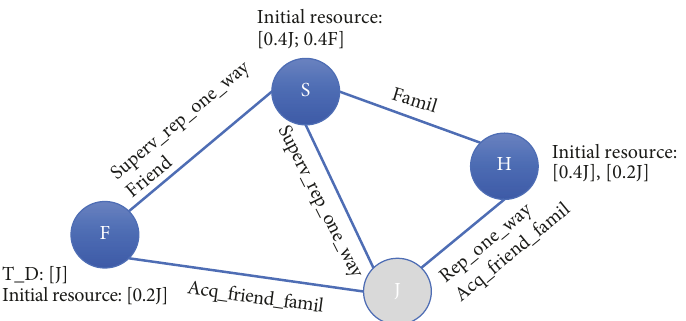
Figure 11: Resource sharing in disruption